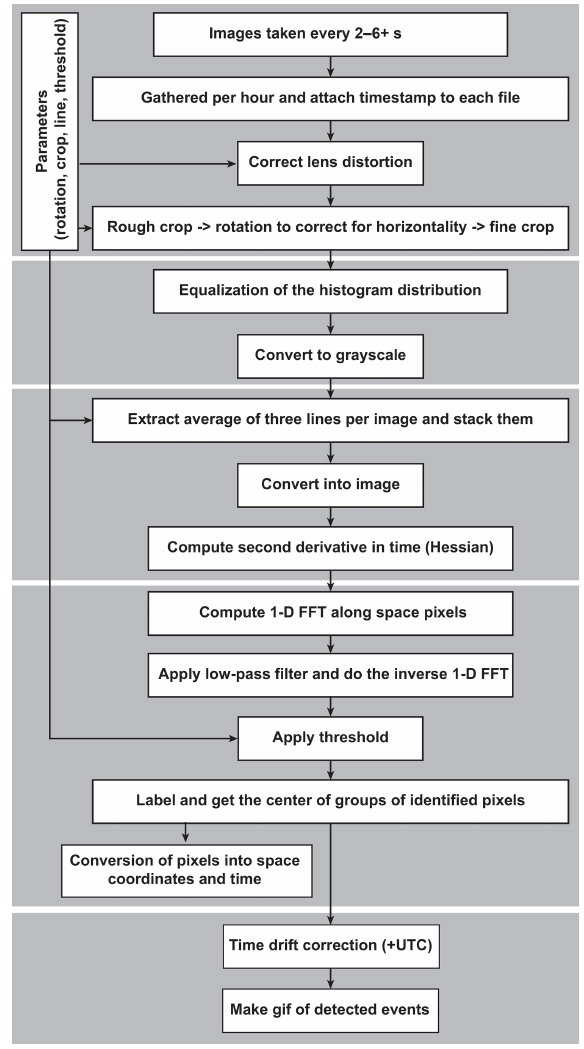
Figure A1. Workflow for detecting calving events in the time-lapse image